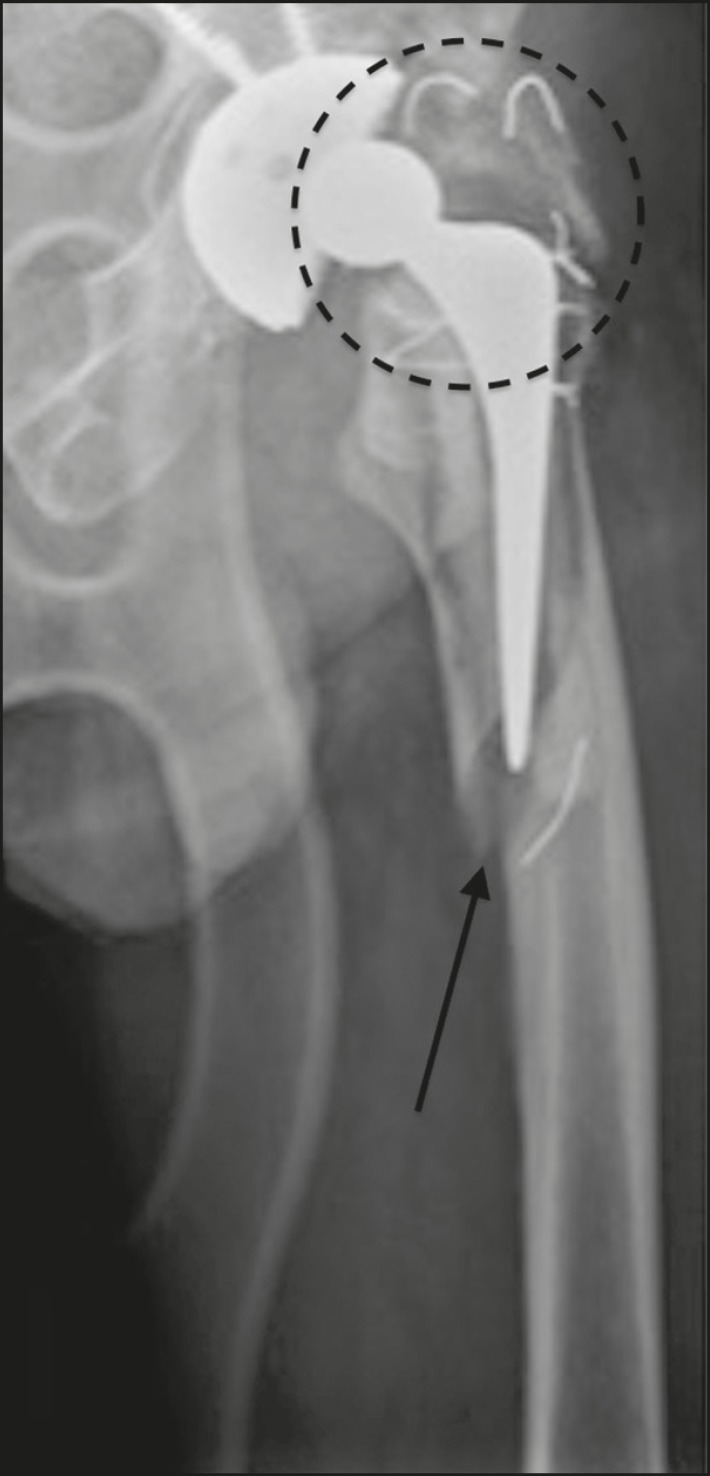
Anteroposterior X-ray of the left hip identifying periprosthetic fracture near the distal femoral stem (arrow), with signs of prosthesis instability (Vancouver subtype B2). Fracture of the greater trochanter with breaks in the metal bands (dotted circle).